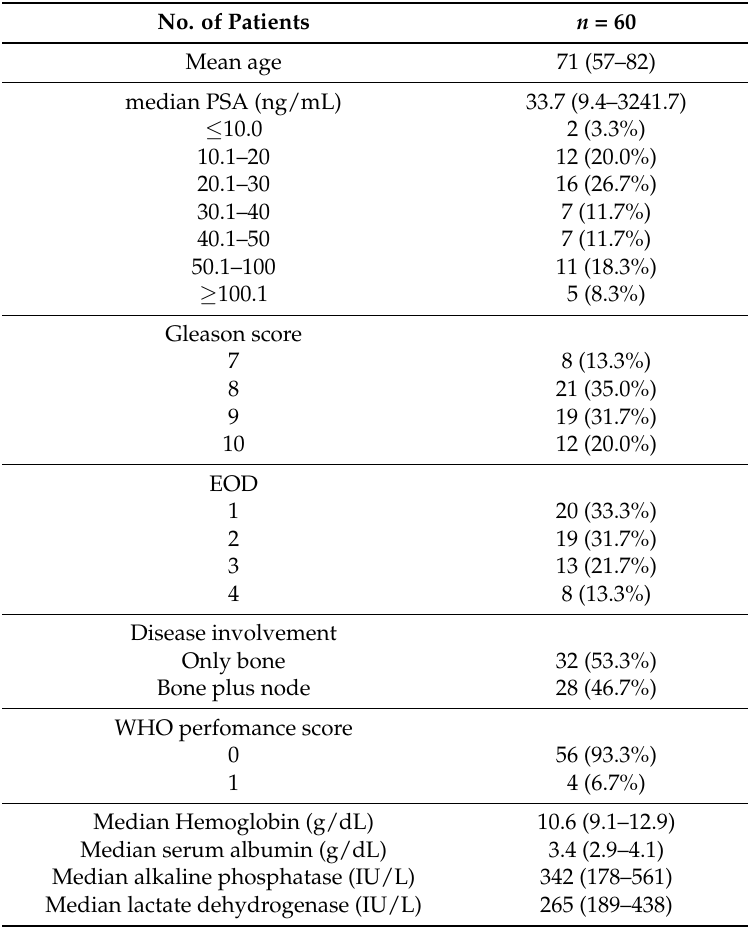
Table 3. Patients’ clinical characteristics per study